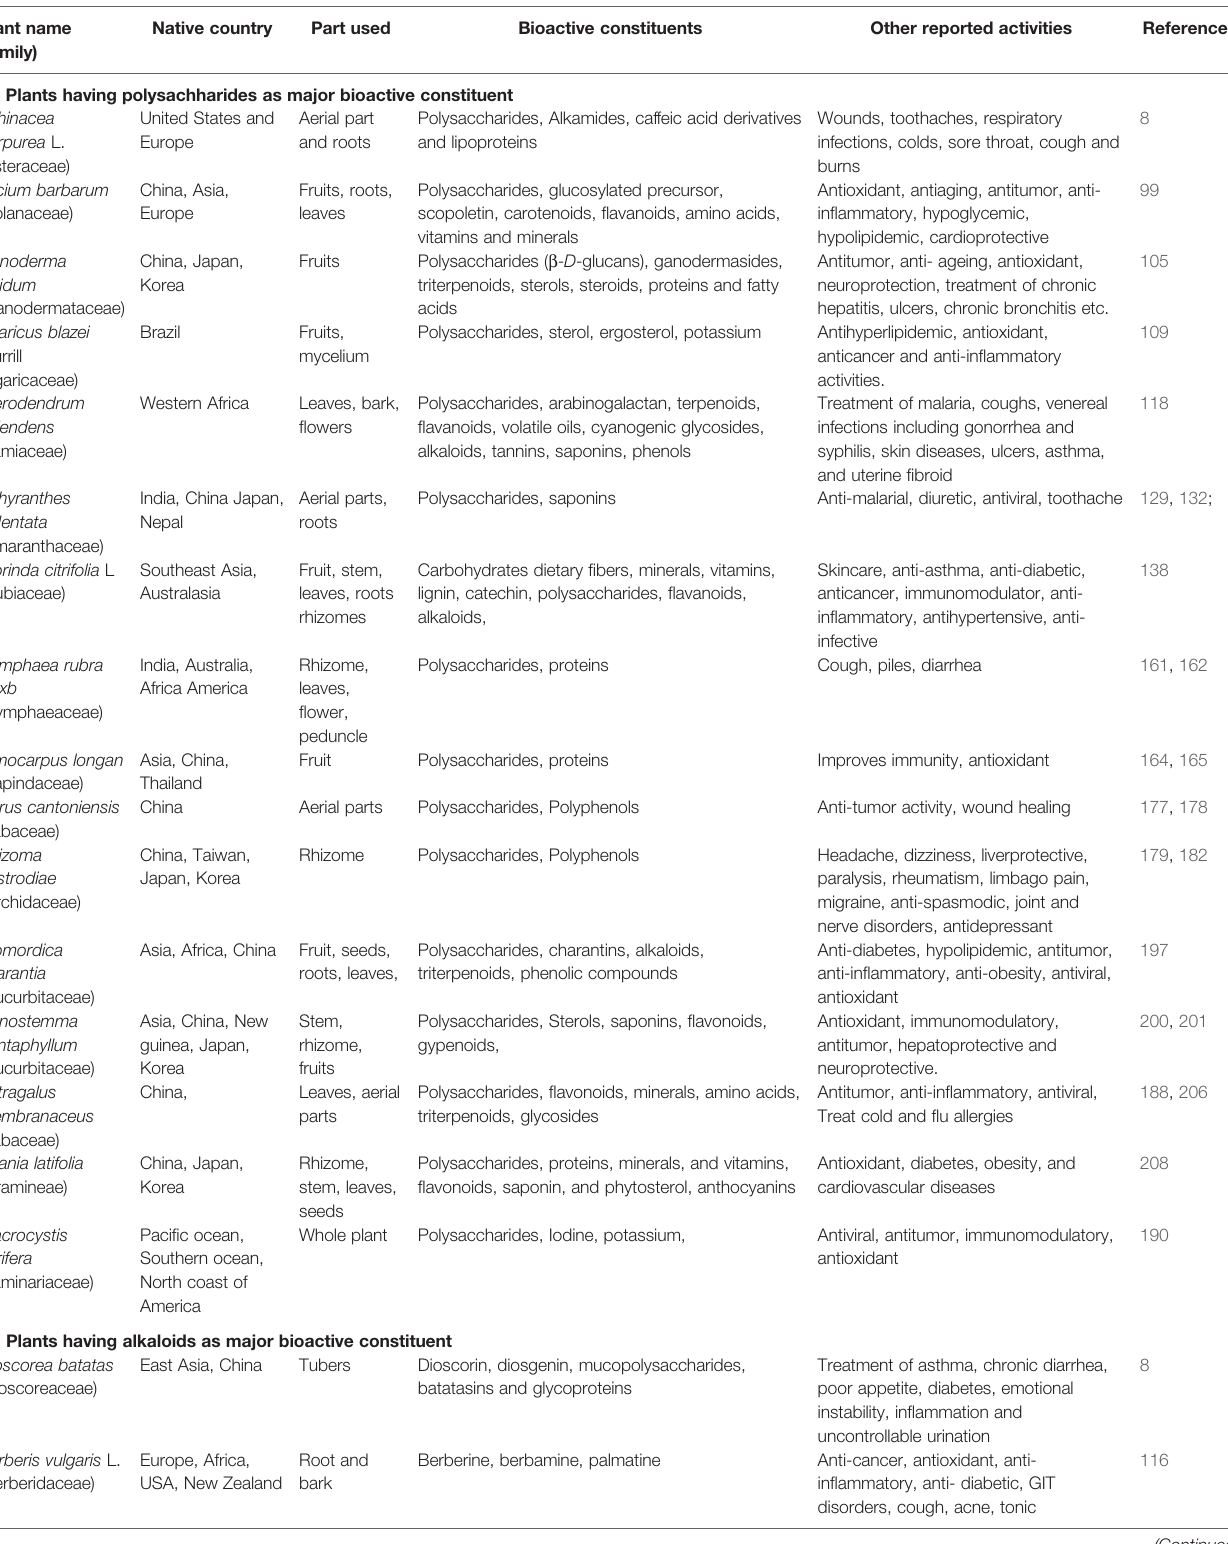
TABLE 1 | List of selected plants demonstrating immunomodulation activity, source countries, parts used, their bioactive chemical constituents and other reported activities. Plant name